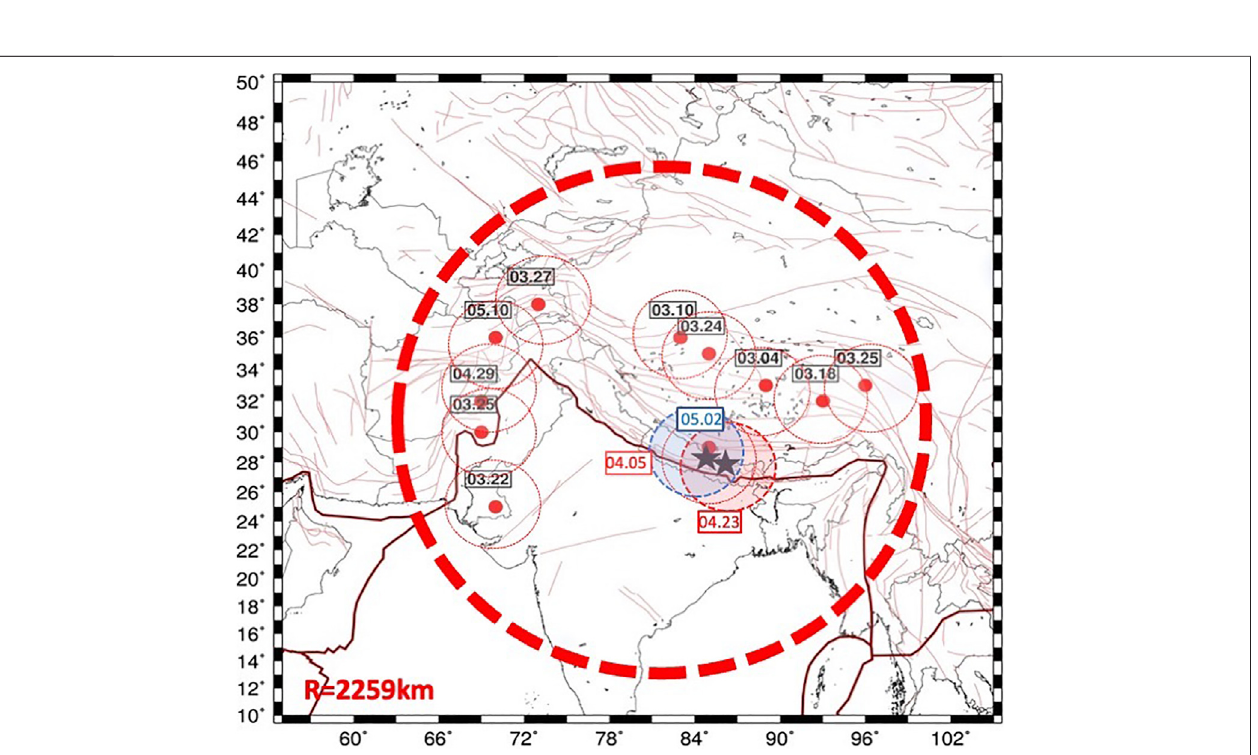
FIGURE 5 | Spatial distribution of Thermal Radiation Anomalies (TRA) March-May 2015 and Dobrvolsky estimated area for the earthquake preparation zone (red dashcircle).Withredshadowedcircles04.03and04.23anomalies.Withablueshadowedcircle05.03.2015anomaly.Withreddots-thecentersofTRAanomalies,with dash red circles, the con fi dence area of TRA. With black stars the epicenters of M7.8 04.25.2015 and M7.3 of05.12.20 15.